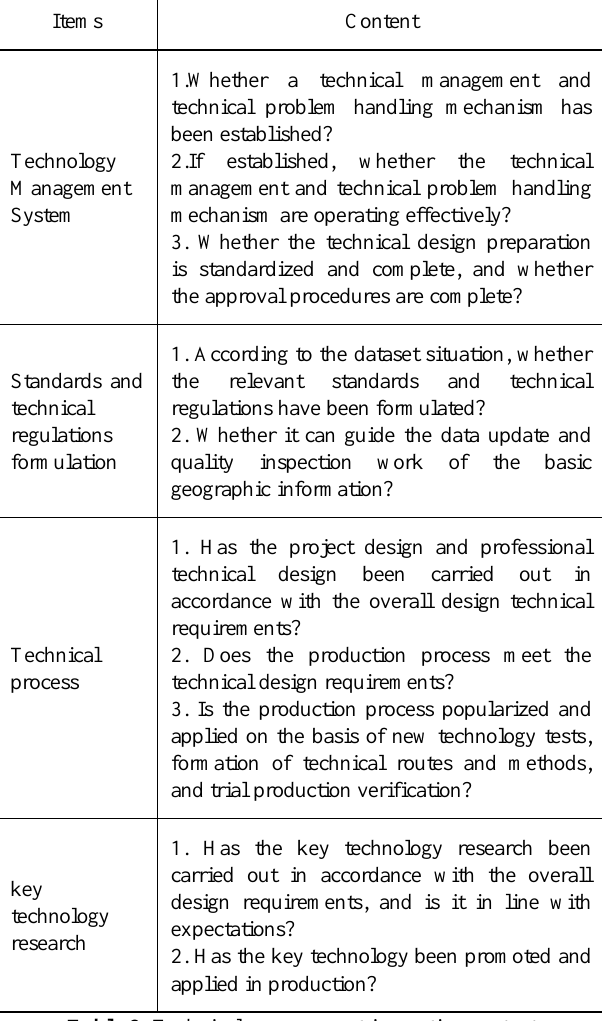
Table 2 . Technical management inspection